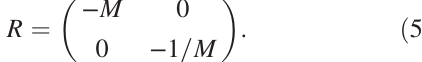
FIG. 2. A schematic layout of a doublet.